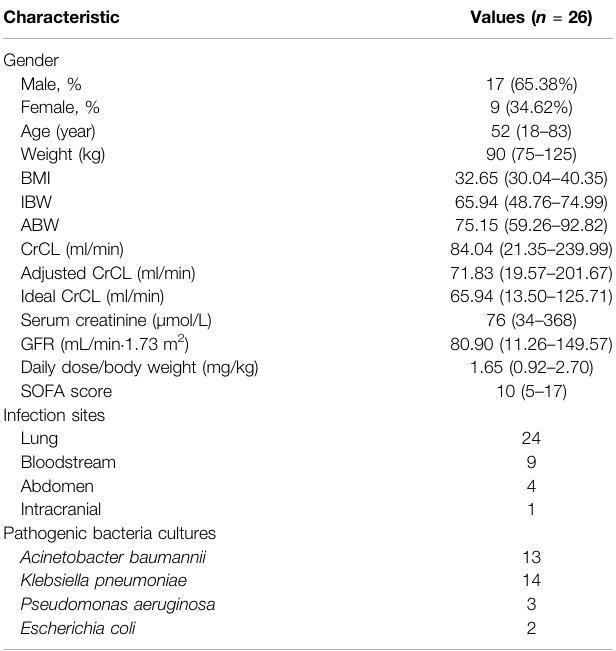
TABLE 1 | Demographic characteristics of